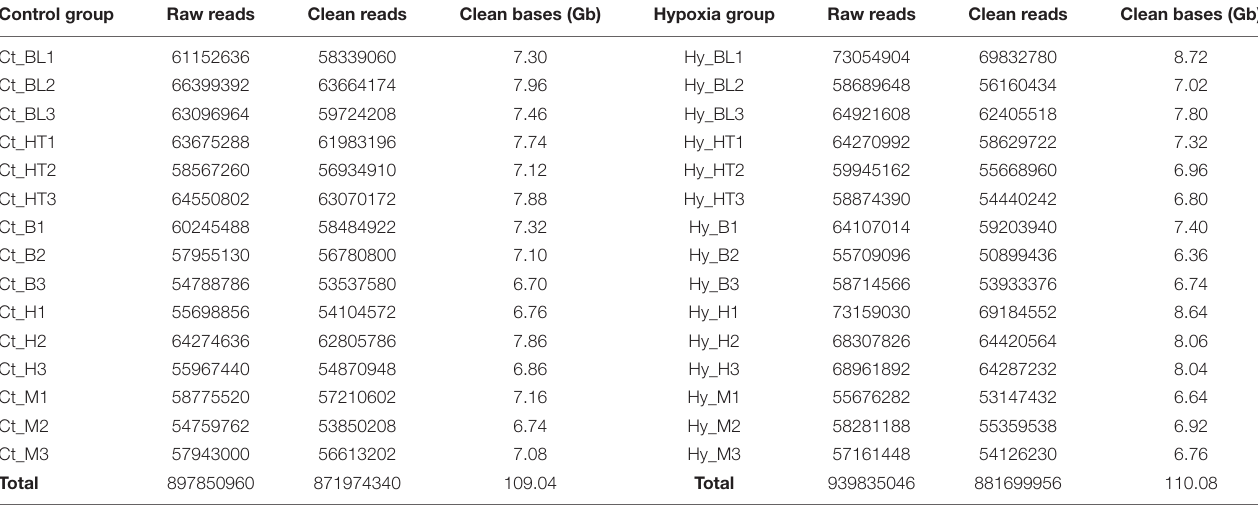
TABLE 1 | Sequencing statistics for individual paired end reads from the RNA-Seq library from G. eckloni . Control group